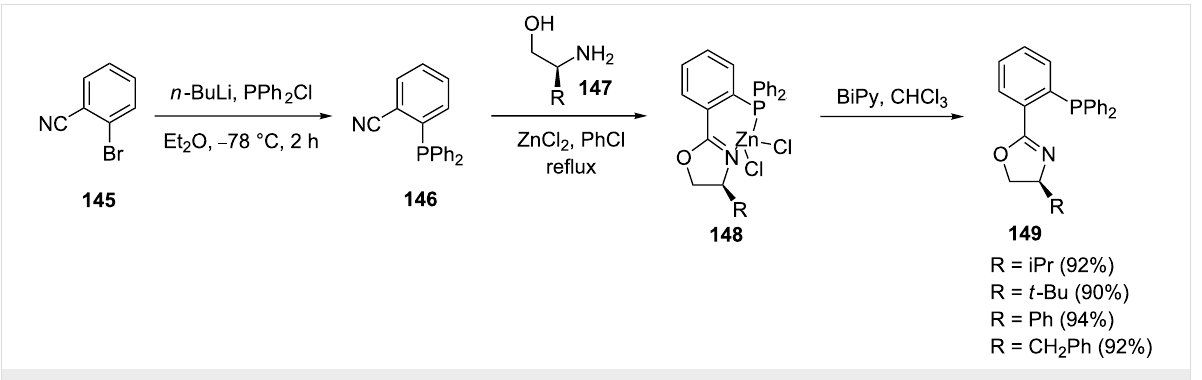
Scheme 28: Synthesis of phosphinooxazolines (PHOX).